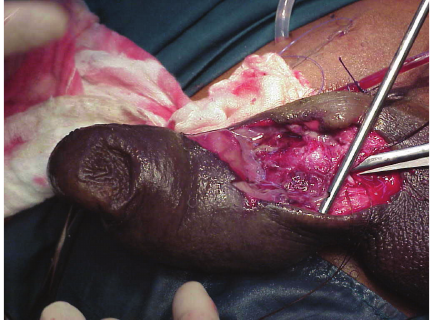
Figure 1: Urethral stone exposed via ventral approach.